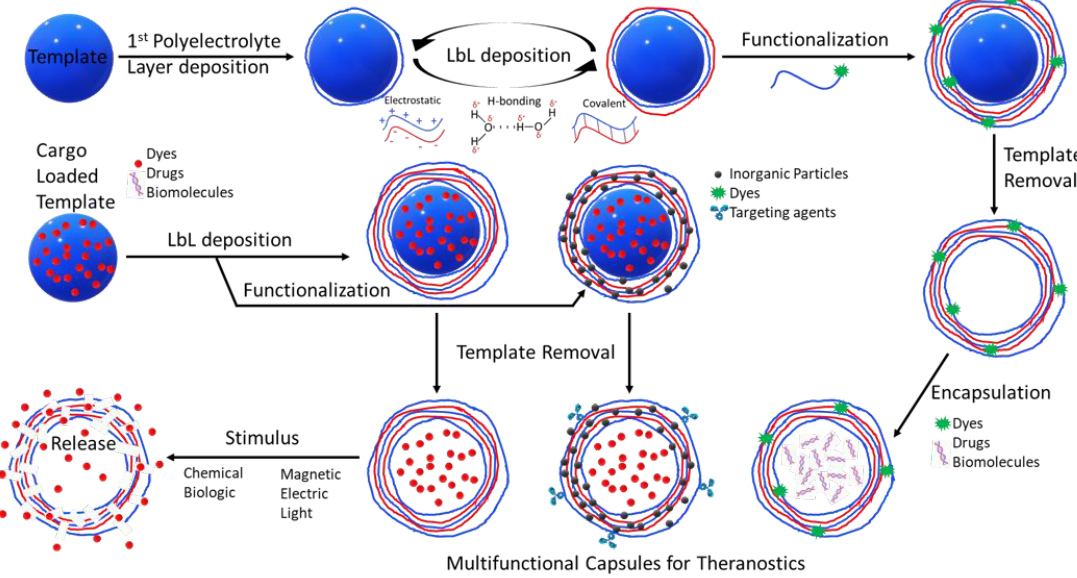
Figure 4. LbL elaboration of capsules. Schematic representation of the different synthesis pathways available to design weak polyelectrolyte multilayer capsules.